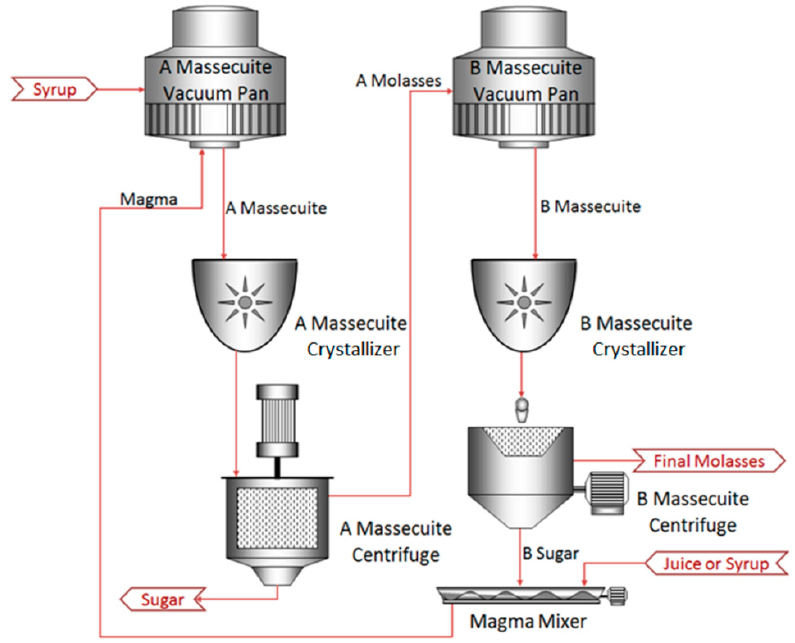
Figure 1. Two massecuites scheme flowchart [4], based on [2].